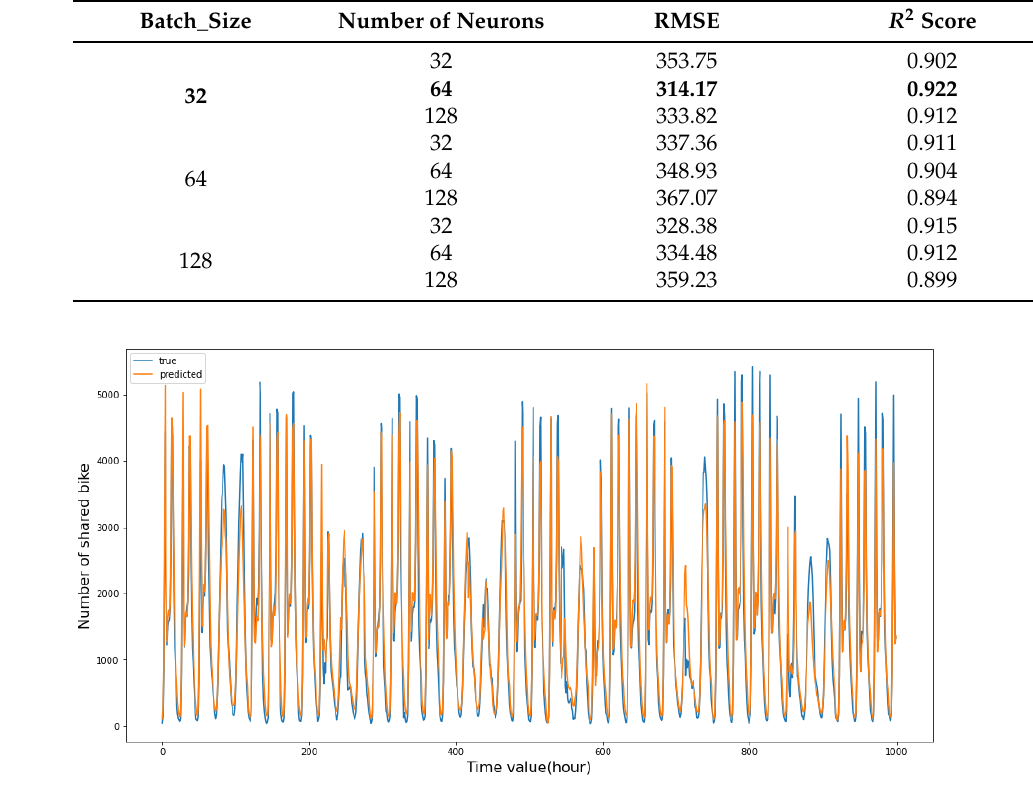
Figure 8. The prediction results of LSTM model.